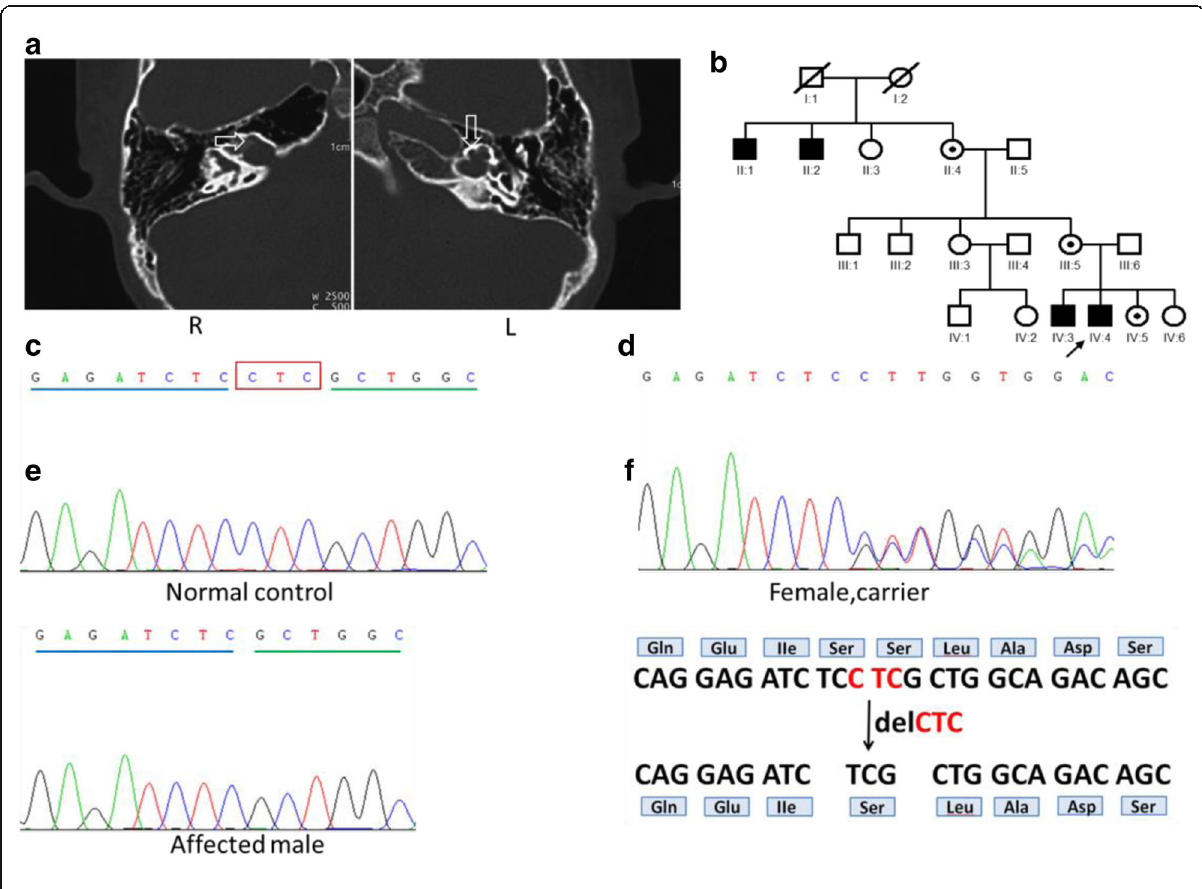
Fig. 1 Pedigree, clinical phenotypes, and mutation analysis in family 1486. a Temporal bone computed tomography (CT) images of the proband of family 1486 demonstrating dilation of the lateral end of the internal acoustic meatus (IAM) and a malformed cochlea; the basal turn of the cochlea was incompletely separated from the IAM (arrow); b Pedigree of Family 1486 with multiple congenital profound sensorineural hearing impairment cases (Affected subjects are denoted in black. Arrow indicates the proband. Mutation carrier are denoted with dot within a symbol); c Wild-type sequence of POU3F4 including sites 927 – 929; d A heterozygous c.927delCTC mutation was found in the female carriers; e A hemizygotic c.927delCTC mutation was detected in the affected males; f Amino acid changes caused by changes in the DNA sequence. A three-nucleotide deletion (from position 927 to 929) in the coding region of POU3F4 results in the deletion of serine at position